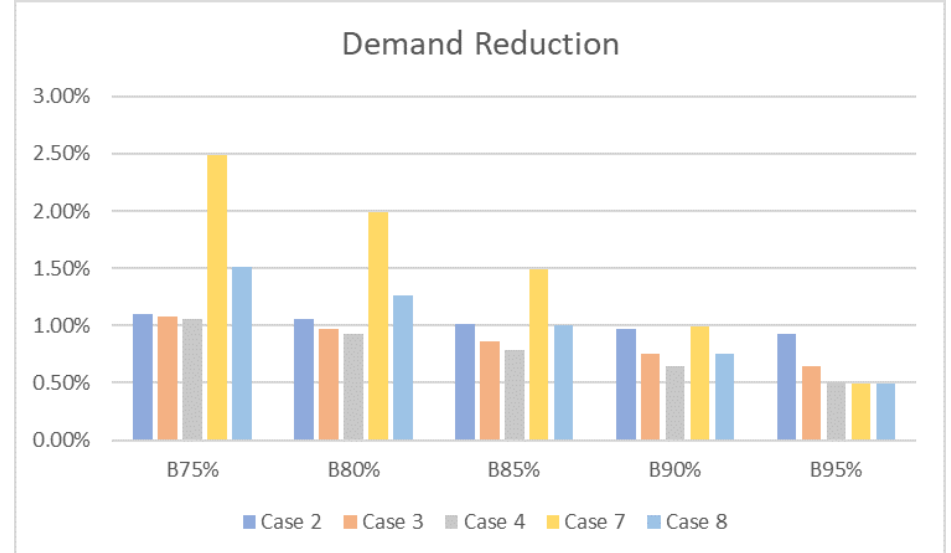
Figure 8. Comparative behavior in weighted scenarios: demand reduction.